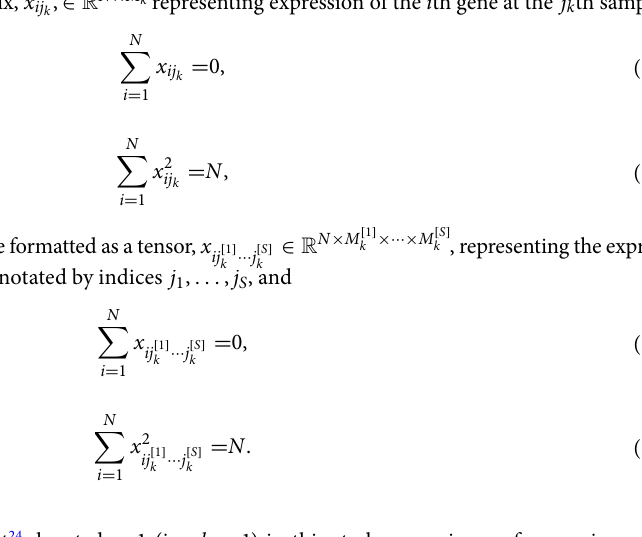
Dataset 1: GSE160224. The dataset 24 denoted as 1 (i.e., k = 1 ) in this study comprises as few as nine sam- ples, including nondemented controls (NDC), three APP duplications, and three isogenically corrected induced pluripotent stem-cell lines. In this study, three control samples are treated as controls, and the other six are measured using RNA-seq technology, while genes are annotated using the Ensembl gene ID. The genes whose expressions are measured numbers as many as 58,302 in contrast to the small number of samples. As a result,